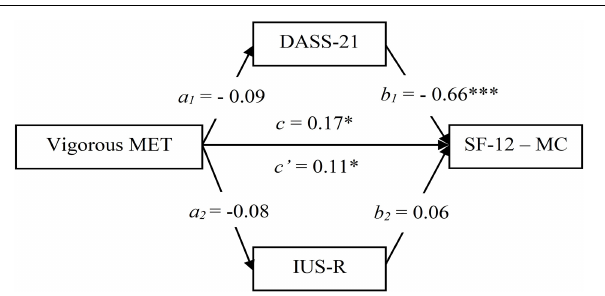
FIGURE 1 | Mediation model testing DASS-21 and IUS-R as mediators of the relationship between Vigorous MET and SF-12 Mental component (M1). ∗ p < 0.05; ∗∗∗ p < 0.001. DASS, Depression Anxiety Stress Scale; IUS, Intolerance of Uncertainty Scale; MET, Metabolic Equivalent Task; SF-12-MC, Short Form Health Survey–Mental